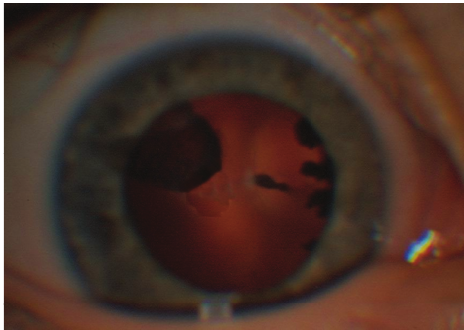
Figure 1: Persistent fetal vasculature